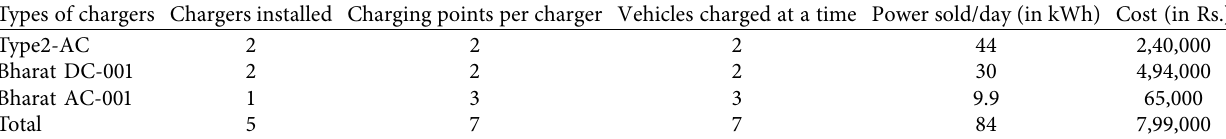
Table 10: Solar powered fast charging station